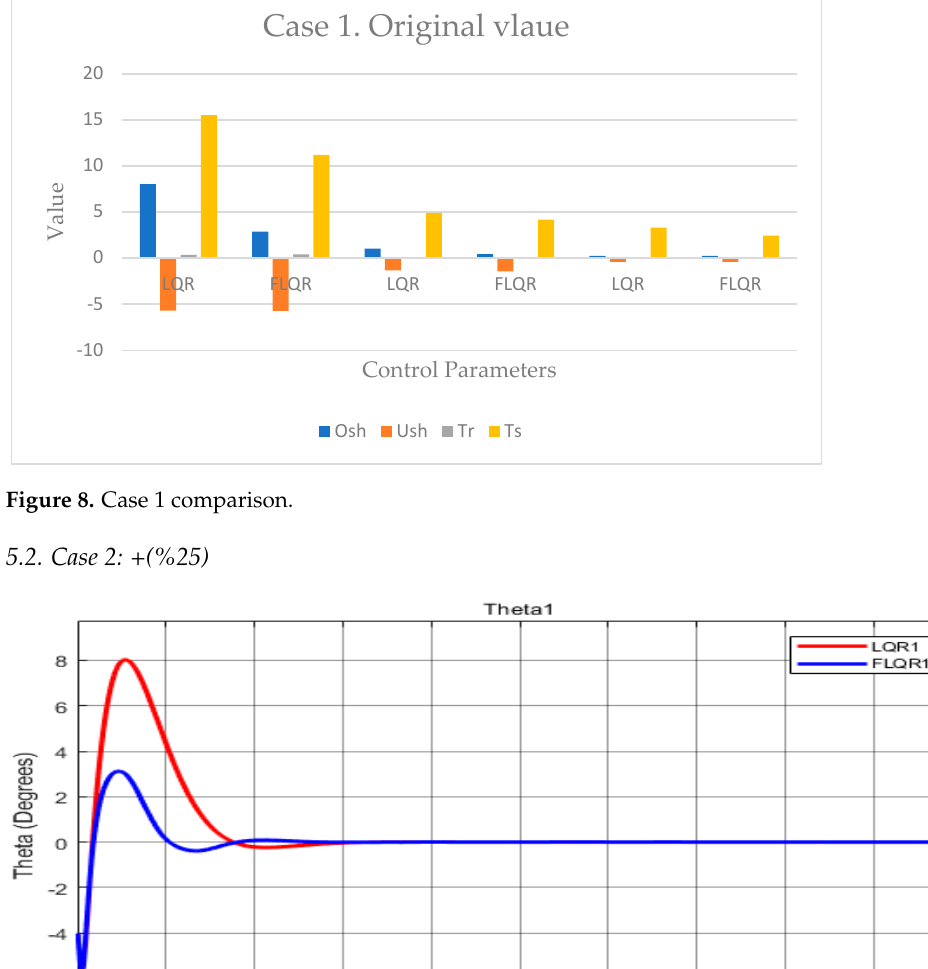
10 ( c ) Figure 7. ( a ) The system response for the upper link of Robogymnast in Case 1 (T1); ( b ) The system response for the middle link of Robogymnast in Case 1 (T2); ( c ) The system response for lower link of Robogymnast in Case 1 (T3). Table 4. LQR vs. FLQR performance [13]. Symbol